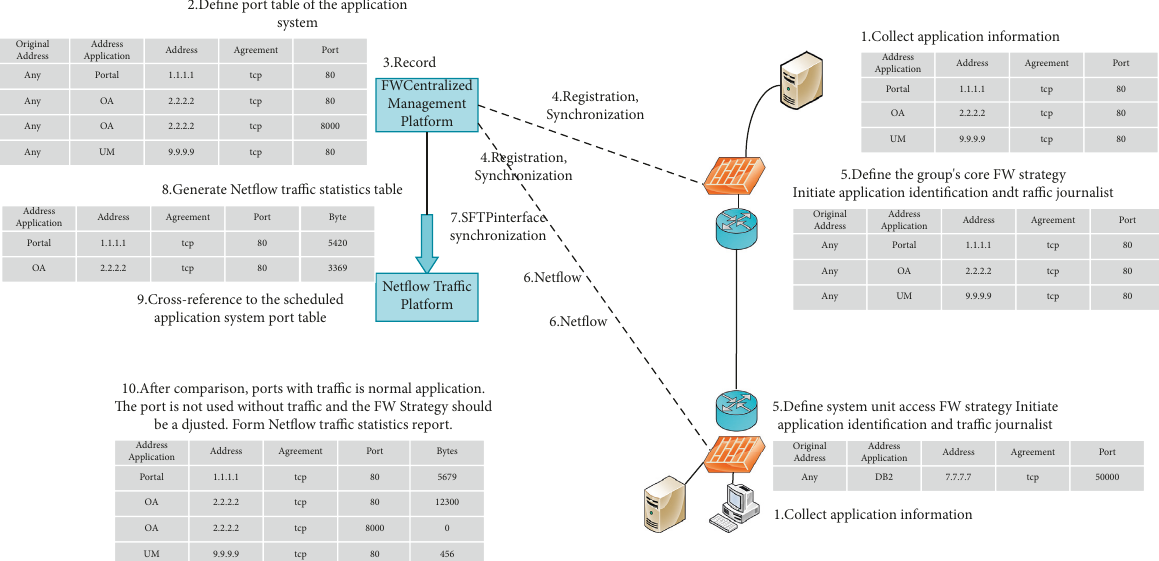
Figure 8: Framework process of fast P2P traffic identification based on decision